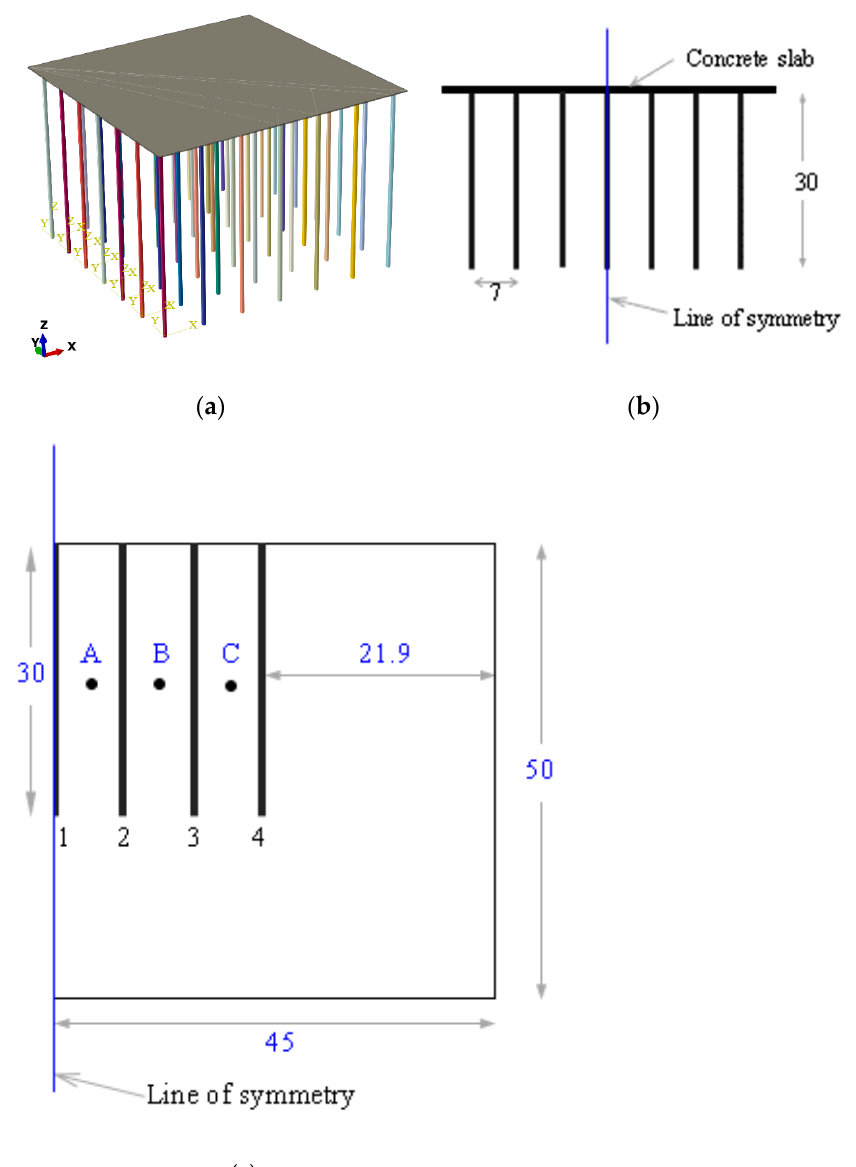
Figure 1. The geometry of the pile group: ( a ) 3D model; ( b ) Side view; and ( c ) Axisymmetric 2D model of the four geothermal energy piles (drawn not to scale). Table 1. Mesh information used for sensitivity analysis. Element Size in Soil Domain GEP (m) No. of Elements Along Radial Axis (m) Along Depth